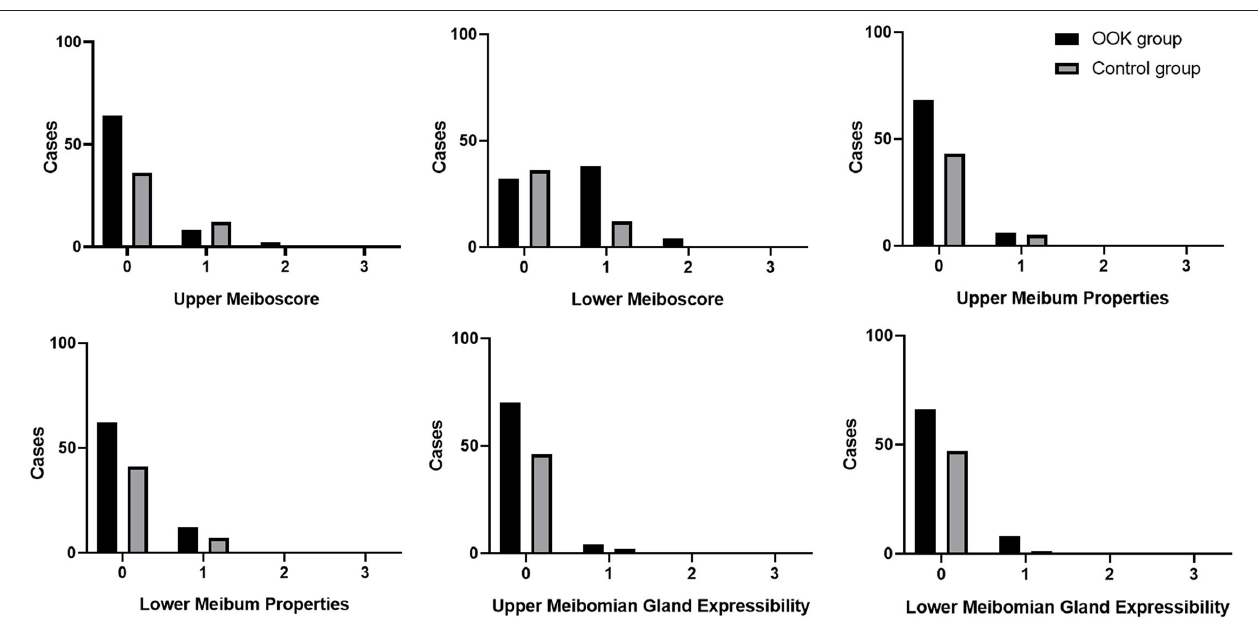
FIGURE 2 | Meiboscore, meibum properties, and meibomian gland expressibility of the upper and lower eyelid in the OOK group and control group.